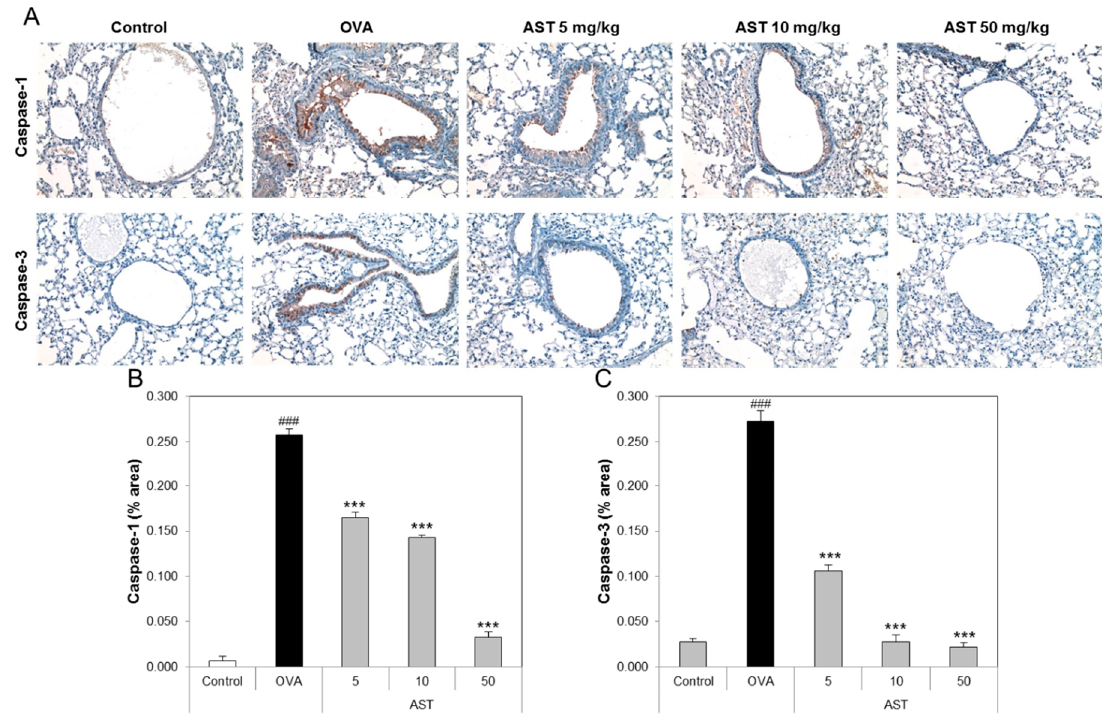
Figure 6. Effect of AST on immunohistochemistry in lung tissue of OVA-induced murine model of asthma. C57BL/6 mice were sensitized and challenged with OVA for asthma induction. At the end of the experiment, the mice lungs were removed. ( A ) The lungs were stained by caspase-1 (×200) and caspase-3 (×200) immunohistochemistry. The percentages of ( B ) caspase 1 or ( C ) caspase 3-positive cells in the lung sections were measured via Image J program. All data were expressed as means ± SD. The data represent three mice per group. ### p < 0.001 control vs. OVA. *** p < 0.001 OVA group vs. AST group.